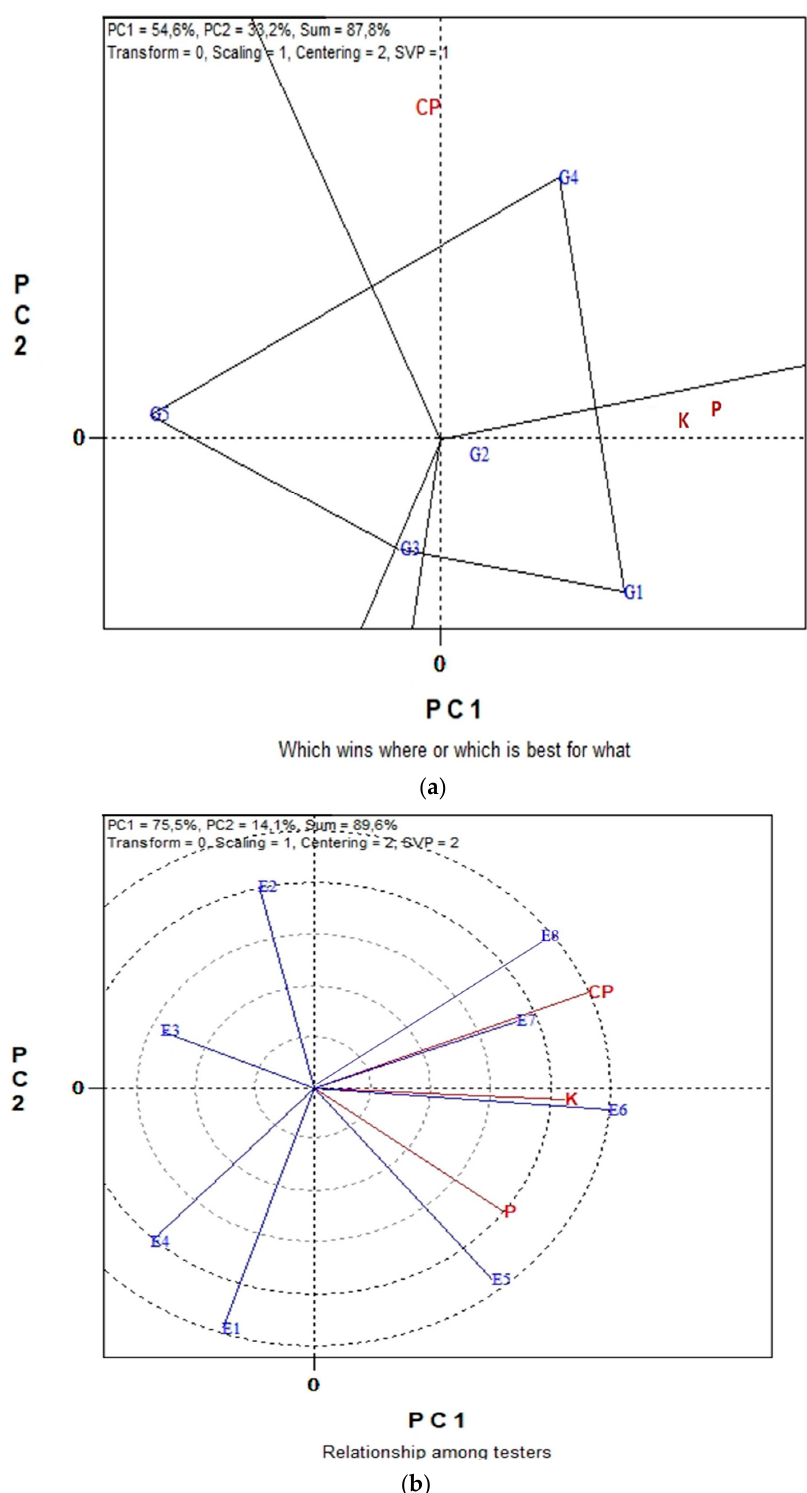
Figure 3. Biplot analysis of seed macronutrient P, K contents and seed crude protein (CP) concen- tration, in organic farming: ( a ) “which-won-where or which is best for what” view of the GGE biplot based on seed macronutrient P, K contents of five lentil genotypes in eight environments; ( b ) “dis- criminating power vs. representativeness” view of the GGE biplot based on seed macronutrient P, K contents of five lentil genotypes in eight environments.